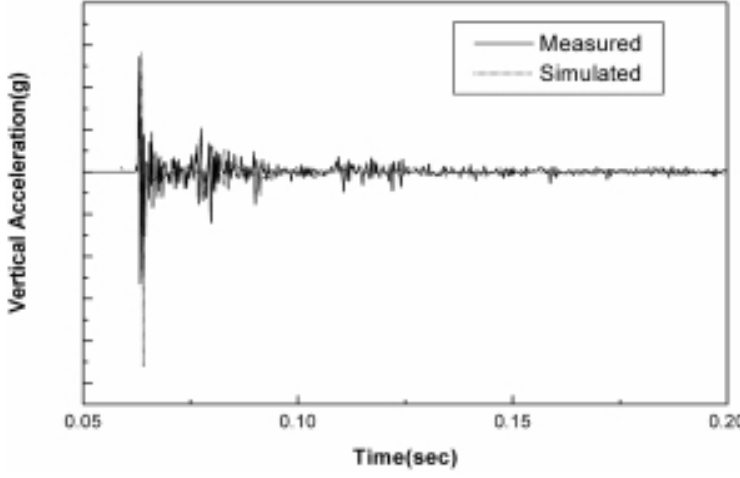
Fig. 12. Comparison of measured and simulated vertical acceleration at bottom